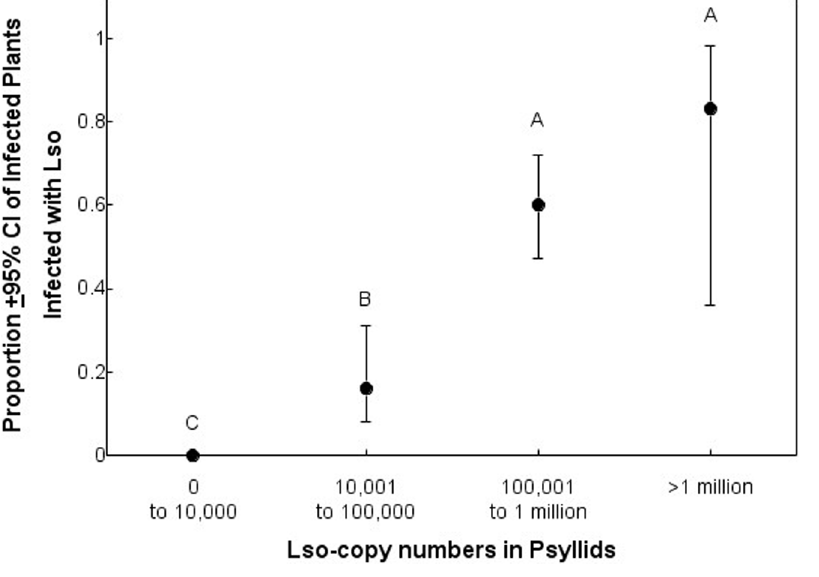
Figure 5. Relationship between Lso copy numbers in psyllids and transmission rates to host plants. Different letters indicate significant differences among Lso copies groups.